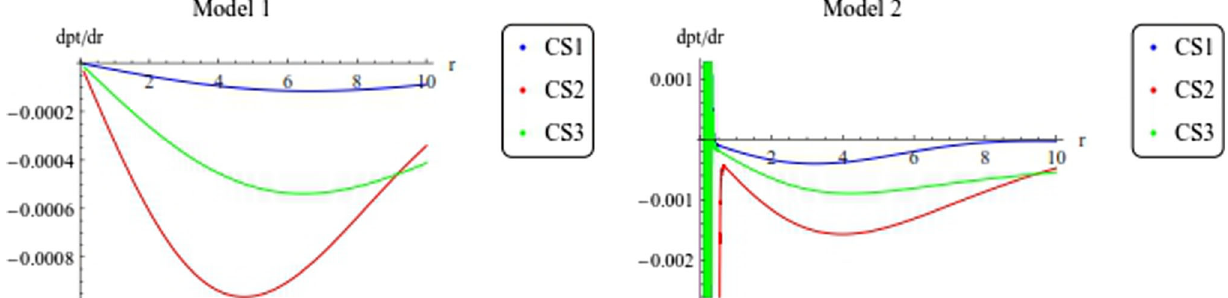
Fig. 6 Graph describing dp t / dr with increasing r for both f ( R ) models